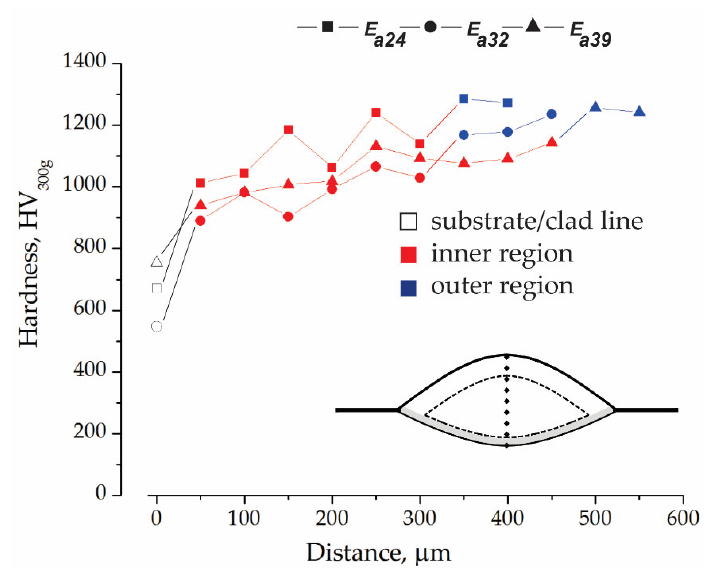
Figure 7. Microhardness profile of the clad for E a24 , E a32 , and E a39 .